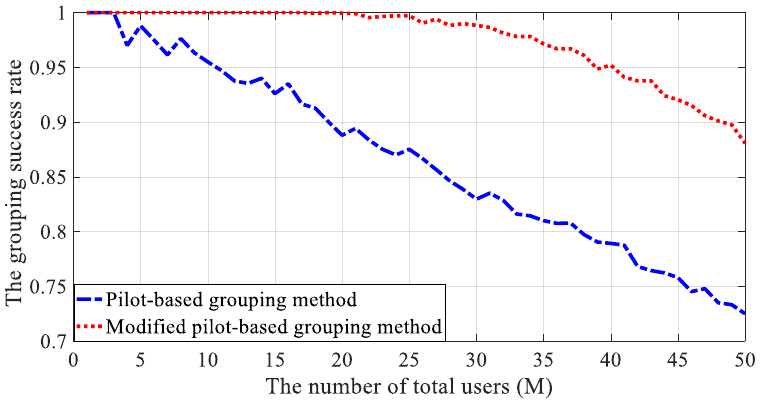
Figure 4. The comparison of the grouping successful rate between the modified pilot-based grouping method and the pilot-based grouping method.